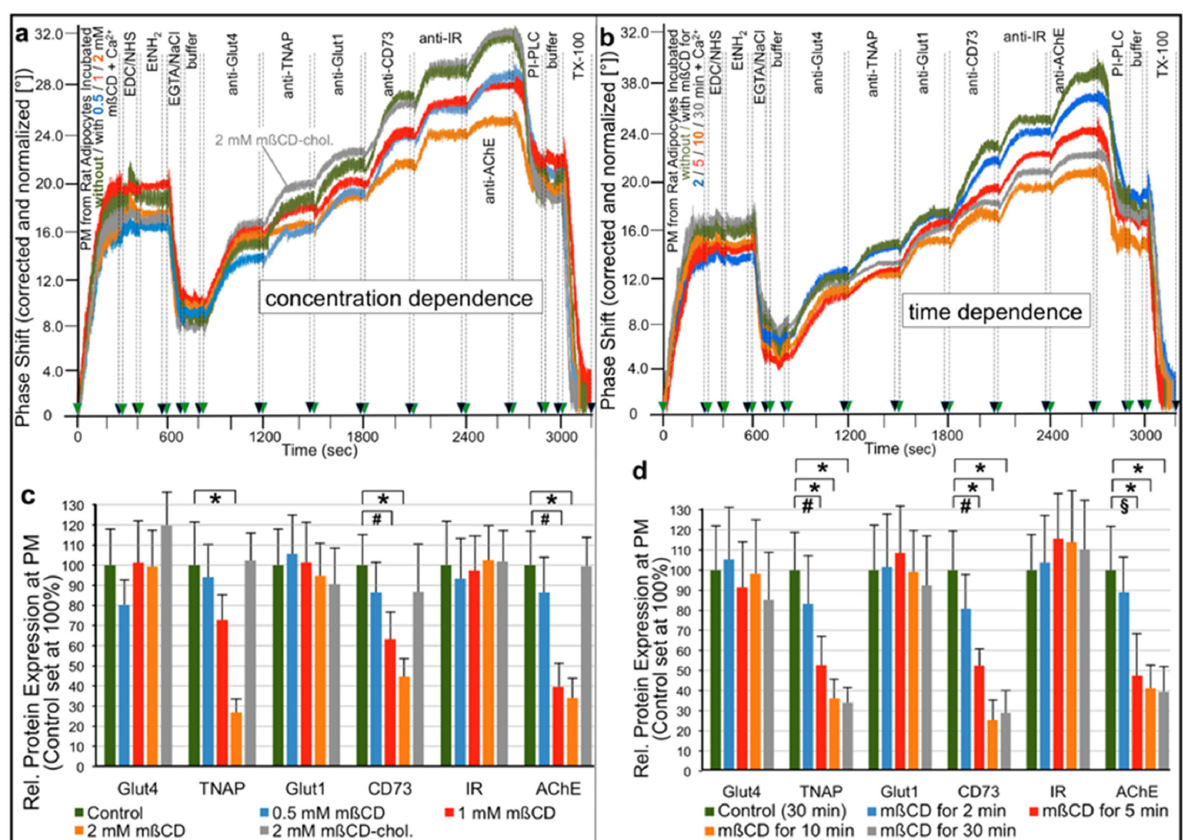
Figure 3. Removal of GPI ‐ APs from PM of rat adipocytes by mßCD. Primary rat adipocytes were incubated ( a , c ) in the absence (green) or presence of increasing concentration of mßCD (blue, 0.5 mM; red, 1 mM; and orange, 2 mM) or 2 mM mßCD in complex with cholesterol (grey, mßCD ‐ chol.) for 10 min or ( b , d ) in the absence (green) or presence of 10 mM mßCD for increasing periods of time (blue, 2 min; red, 5 min; orange, 10 min; and grey, 30 min) as described in Materials and Methods. The expression of transmembrane proteins and GPI ‐ APs at PM, prepared from the adipocytes, was analyzed by SAW sensing. ( a , b ) PM from representative adipocyte preparations analyzed by different chips are shown and were repeated three to five times with similar results. The measured phase shift is given upon correction as described in the legend to Figure 1. ( c , d ) The values from four to six independent adipocyte preparations for both control and mßCD treatment were used for calculation and normalization of the phase shift Δ induced by each antibody. The mean values + SD of the phase shift Δ were used for calculation of the relative protein expression at PM with control adipocytes set at 100% each and significant differences vs. mßCD ‐ treated ones indicated (* p < 0.01, # p < 0.02, § p < 0.05). endogenous GPI ‐ APs, GPI ‐ deficient EL cells, ManN ‐ treated rat adipocytes and mßCD ‐ treated human adipocytes were incubated with micelle ‐ like GPI ‐ AP complexes, which